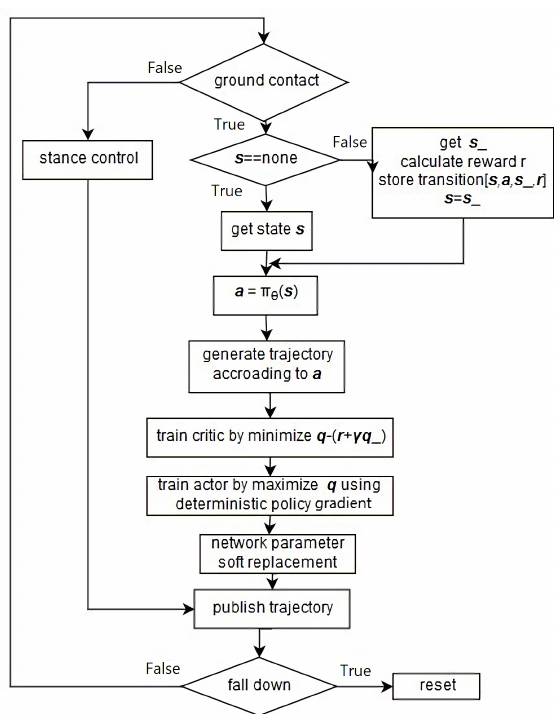
Figure 3. Flow diagram of DDPG network training process.